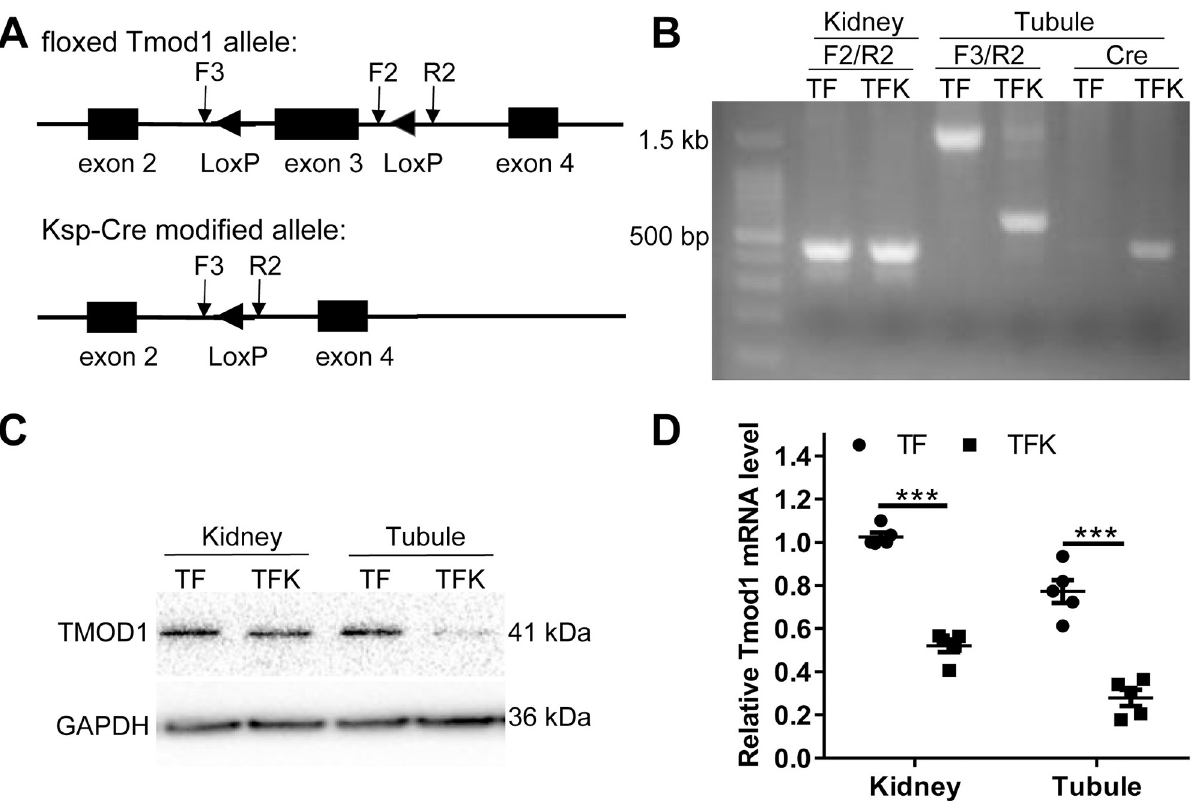
Fig 2. The construction and validation of renal tubule-specific Tmod1 knockout mouse model. (A) Schematic diagram showing gene structures of the floxed Tmod1 allele and Ksp-Cre modified allele. LoxP sites were inserted flanking exon 3 of Tmod1 gene. The expression of Cre recombinase in renal tubules results in the excision of exon 3. The positions of genotyping primers, F2, F3 and R2, were marked in the diagram. (B) Genotyping of renal tubule-specific Tmod1 knockout mice by PCR. The genomic DNAs were isolated from kidneys and manually isolated tubules of Tmod1 flox/flox /Ksp-Cre + (TFK) and Tmod1 flox/flox /Ksp-Cre − (TF) mice. Primer sets, F2/R2, F3/R2 and Cre primers were used and their corresponding PCR products were 461 bp, 617 bp (in TFK) or 1.5 kb (in TF), and 420 bp, respectively. The products were separated in agarose gel. (C-D) Validation of renal tubule-specific Tmod1 knockout mice. Protein or RNA were isolated from kidneys and and manually isolated tubules of TF and TFK mice. The expression of TMOD1 was detected by Western blot (C) or qPCR (D). GAPDH was used an internal control. ��� : p < 0.001.